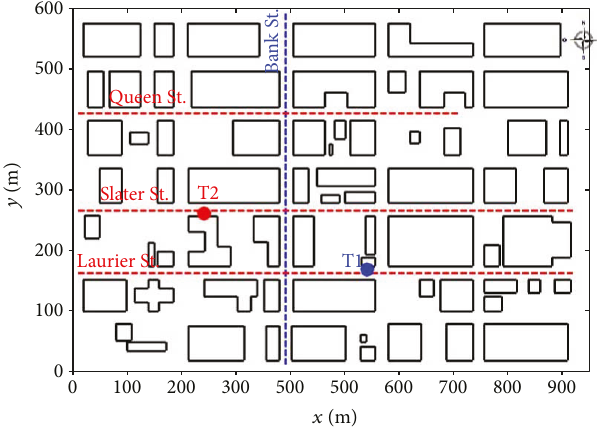
Figure 10: The 2D urban model of Ottawa, Canada.